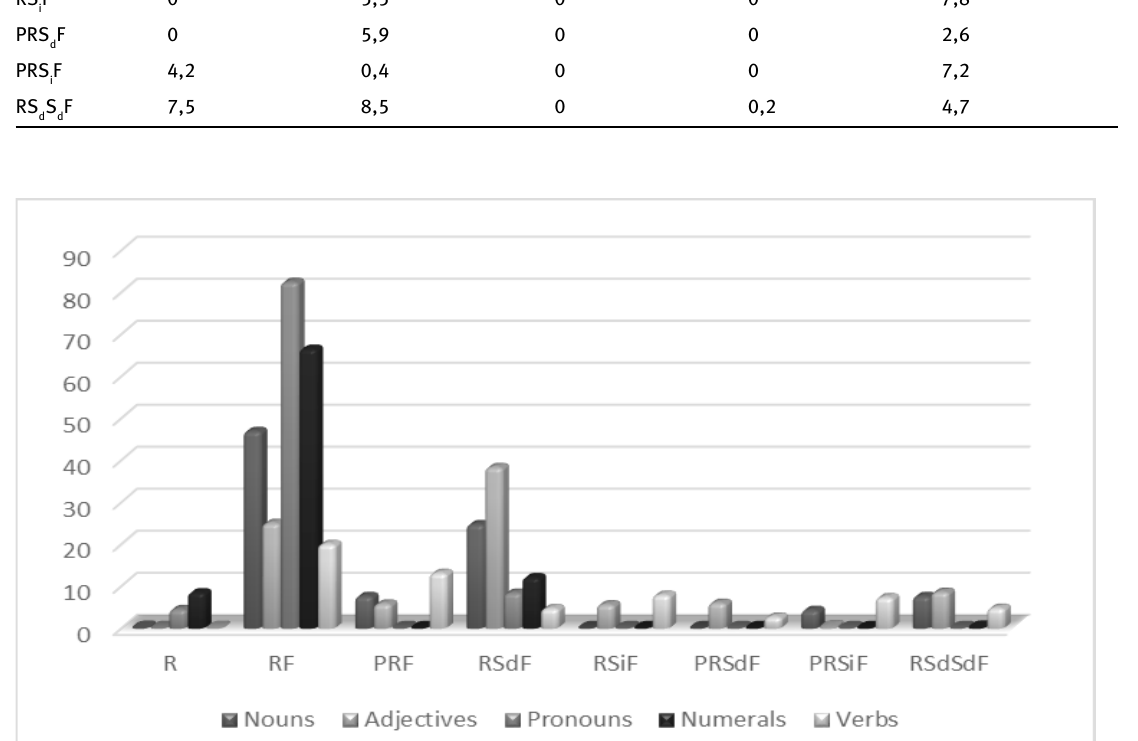
Figure 7. Distribution of Morphemic Models across Different Parts of